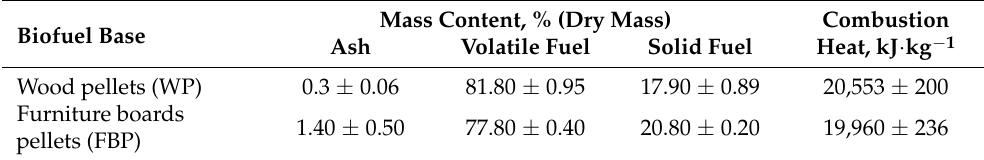
Table 3. Fuel composition of prepared base